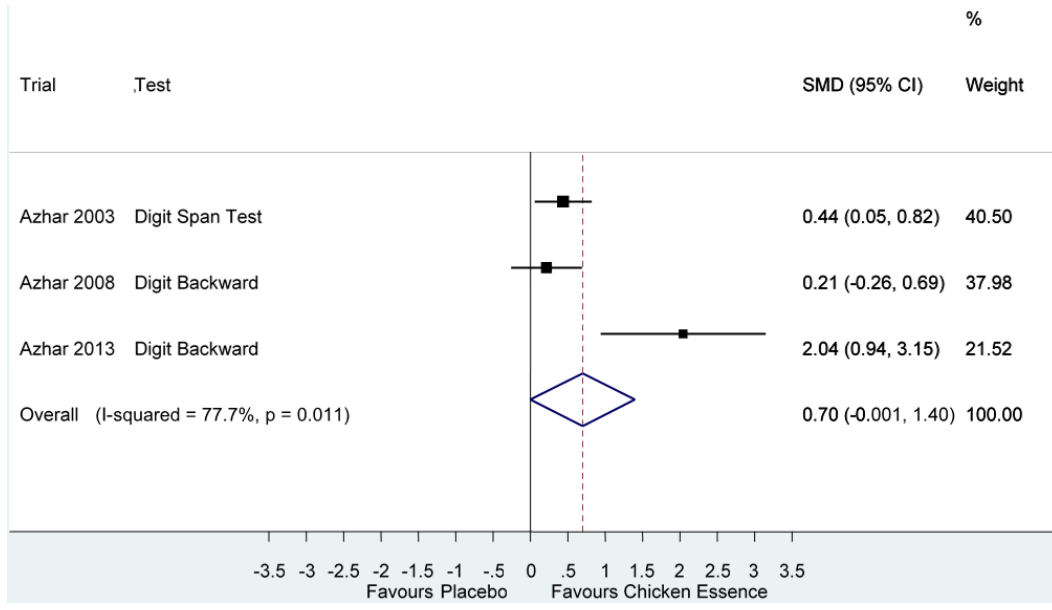
Figure C2. Pooled effect estimate of score of longest list of digits remembered of executive function tests.